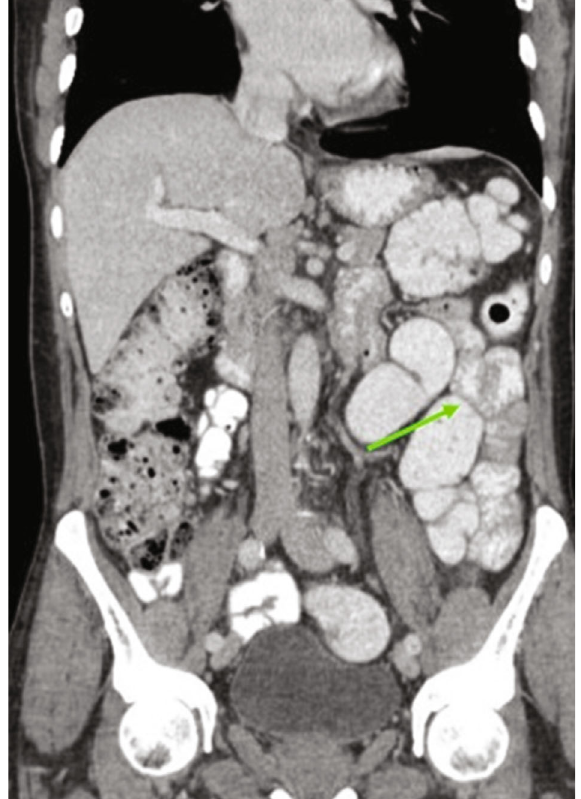
Figure 3: CT abdomen and pelvis with IV, oral, and rectal contrasts showing the jejunal loops project lateral to the sigmoid in the left lumbar region (green arrows).